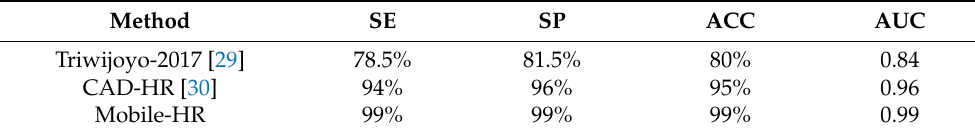
Table 6. Performance comparison between the Mobile-HR, Triwijoyo-2017, and CAD-HR systems for the diagnosis of HR-related eye disease.